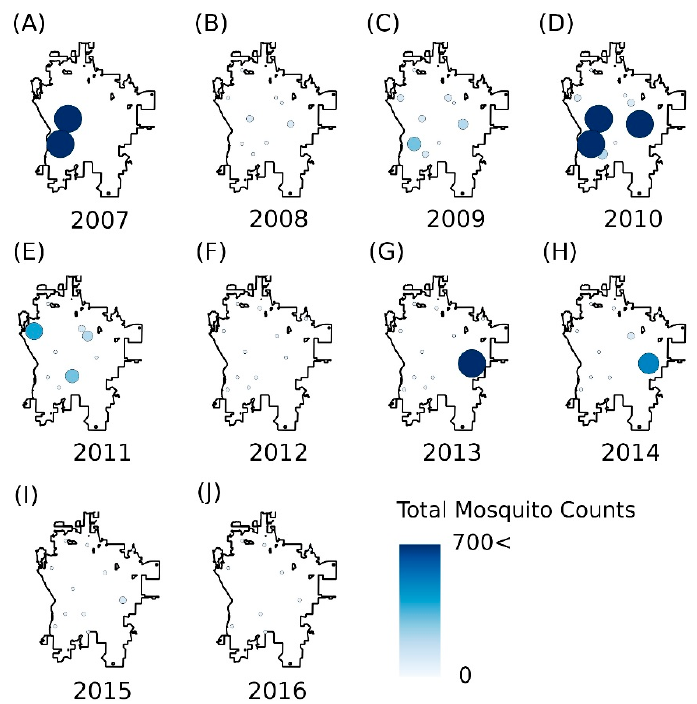
Figure 3. Maps showing the yearly total of mosquitoes from 2007 to 2016 ( A – J ). The area of the circle and color show the mosquito numbers (count). It is evident from the annual maps that the numbers and locations of mosquito fluctuate from year to year.